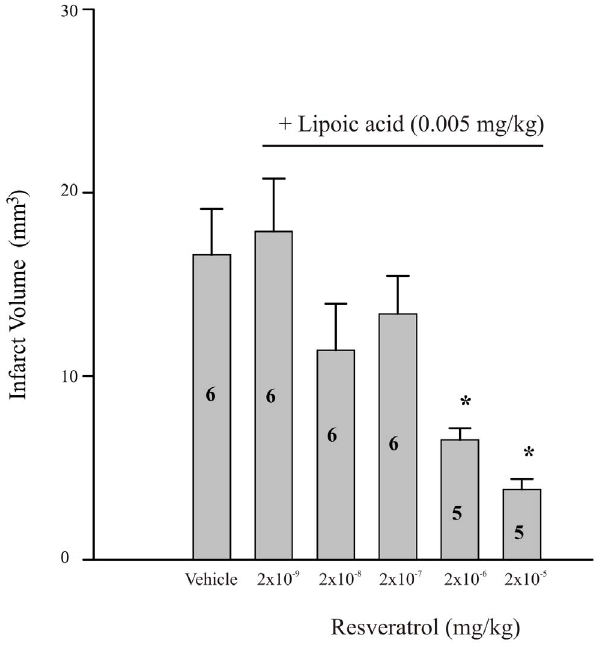
Figure 3. Effect of increasing doses of resveratrol in combina- tion with lipoic acid on infarct volume. Bar graph summarizing the effect of co-administration of a sub-threshold dose of lipoic acid (0.005 mg/kg) with increasing doses of resveratrol on infarct volume following ischemia/reperfusion. Each bar represents the mean 6 S.E.M. (n=5–6/group) and * indicates significance ( p # 0.05) from the vehicle- treated (propylene glycol 4 6 10 2 3% (v/v)) control group.